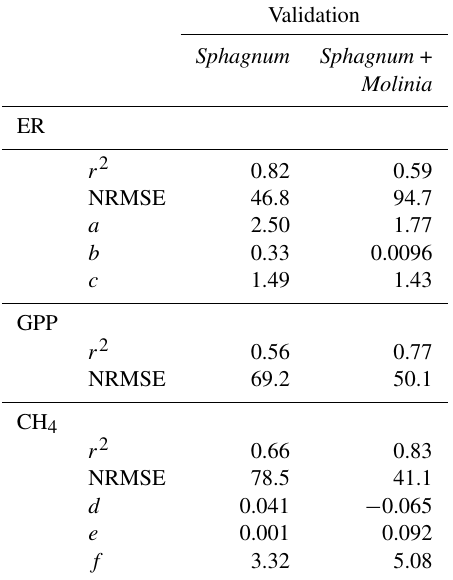
Table 3. Modeled annual gross primary production (GPP;